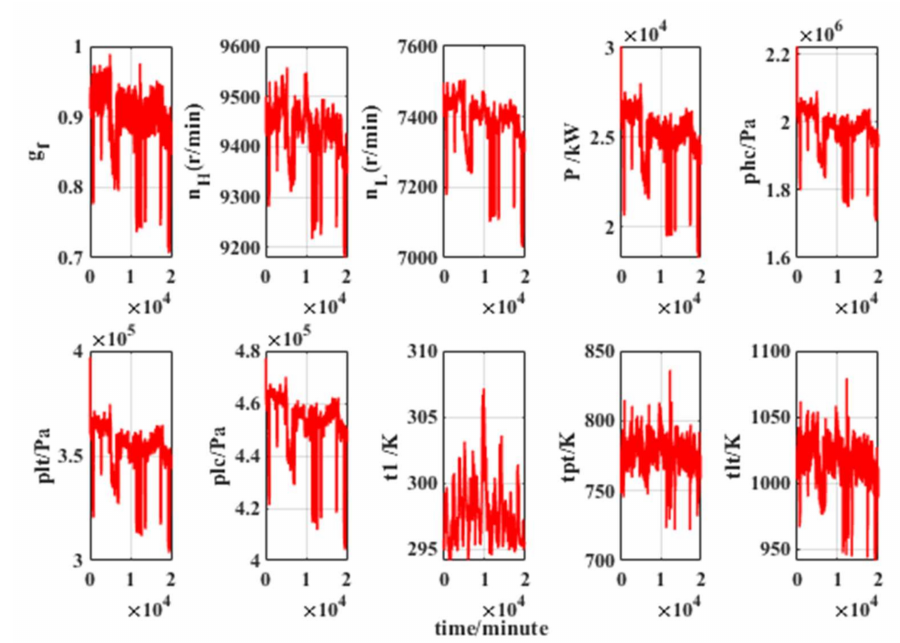
Figure 8. Normal data in the